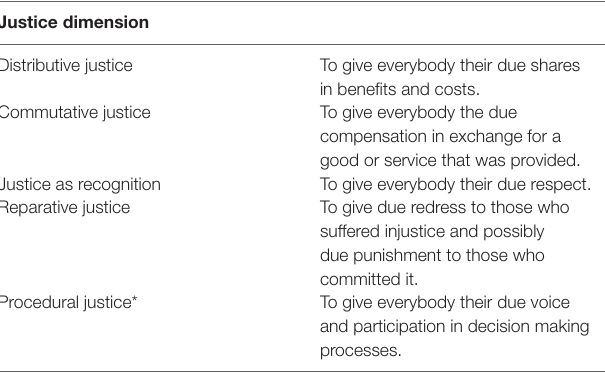
TABLE 1 | Comparing the different justice dimensions when justice in general means that everybody gets his or her due. Justice dimension Distributive justice To give everybody their due shares in benefits and